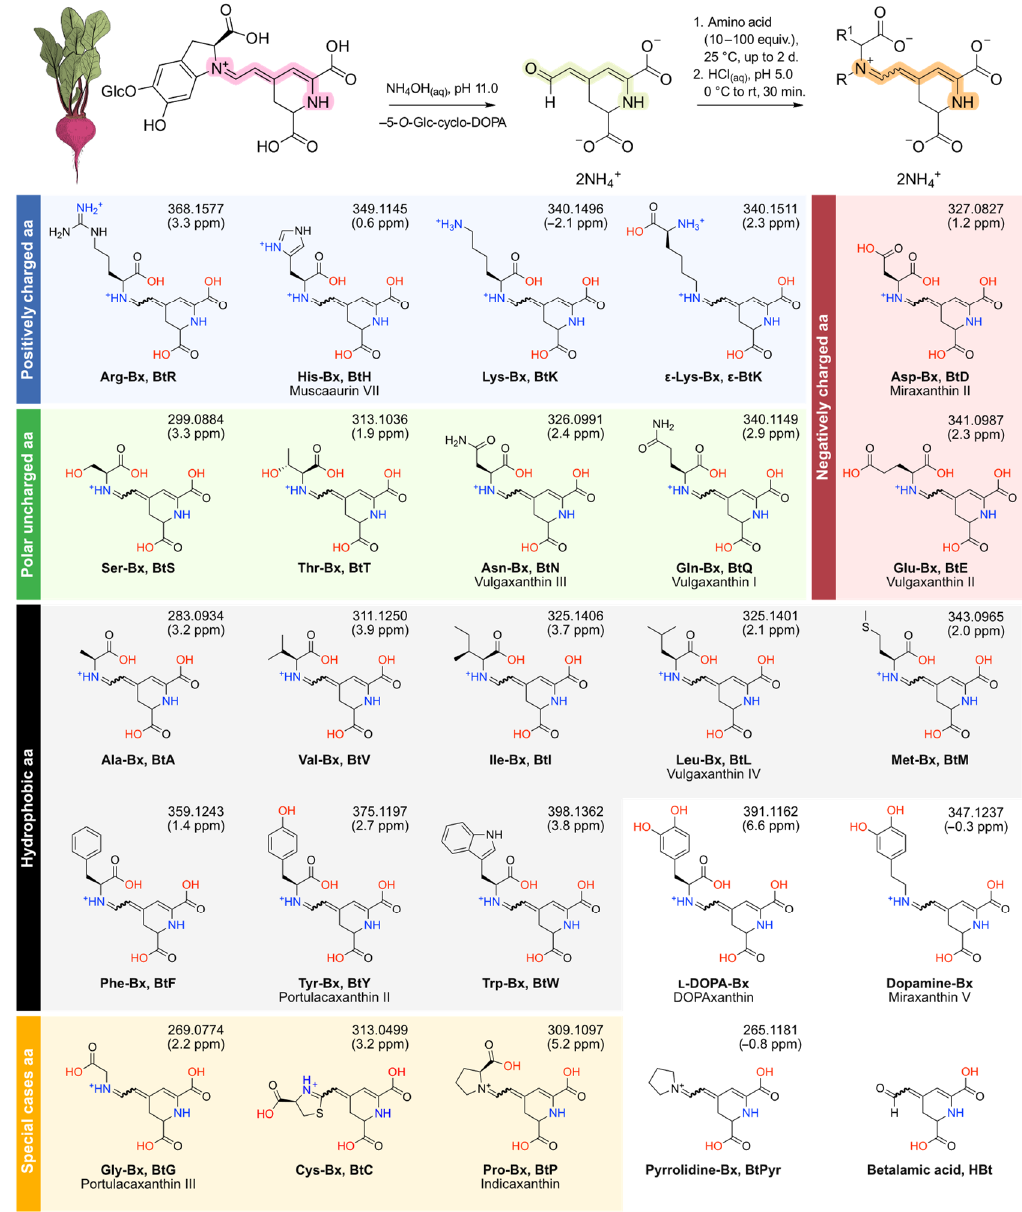
Figure 1. Semisynthesis of amino acid betaxanthins and chemical structures of the betaxanthins prepared and their common precursor, betalamic acid. The betaxanthins are in the form of ammonium salts before purification. Compounds are classified according to the properties of their precursor amino acids (aa) and are presented in the fully protonated form for clarity. The wavy bond indicates that both diastereomers are formed. R is the substituent at the amino group of the aa or hydrogen; R 1 represents the side chain. Numbers at the top of each structure are the observed m/z and the difference between the calculated and observed m / z values, in parts per million (ppm). Mass